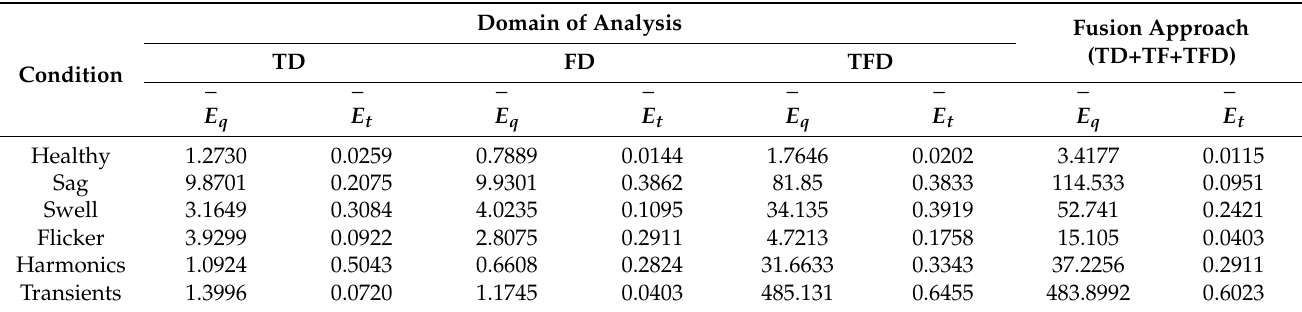
Table 5. Achieved values of E q and E t resulting from the feature learning procedure performed by the proposed SOM neuron grid